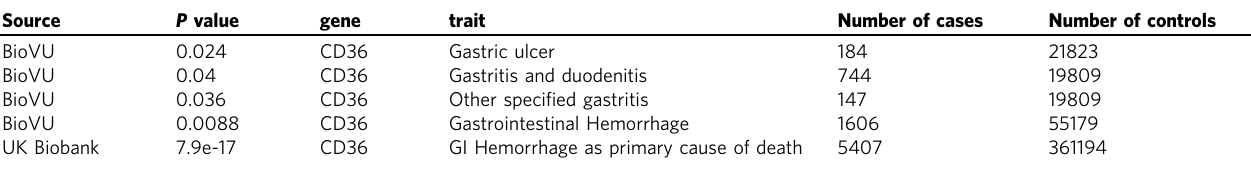
Table 1 Low CD36 expression associates with susceptibility to gastric disorders.